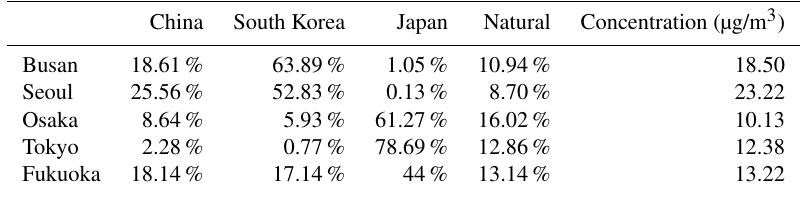
Table 2. Contributions from China, South Korea, and Japan to surface PM 2 . 5 (in percent) in five cities.